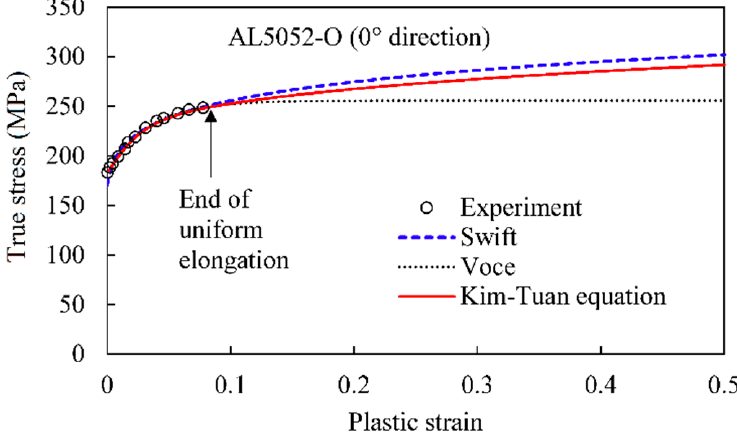
Figure 2. Curve fitting results for the AL5052-O sheet in the rolling direction.